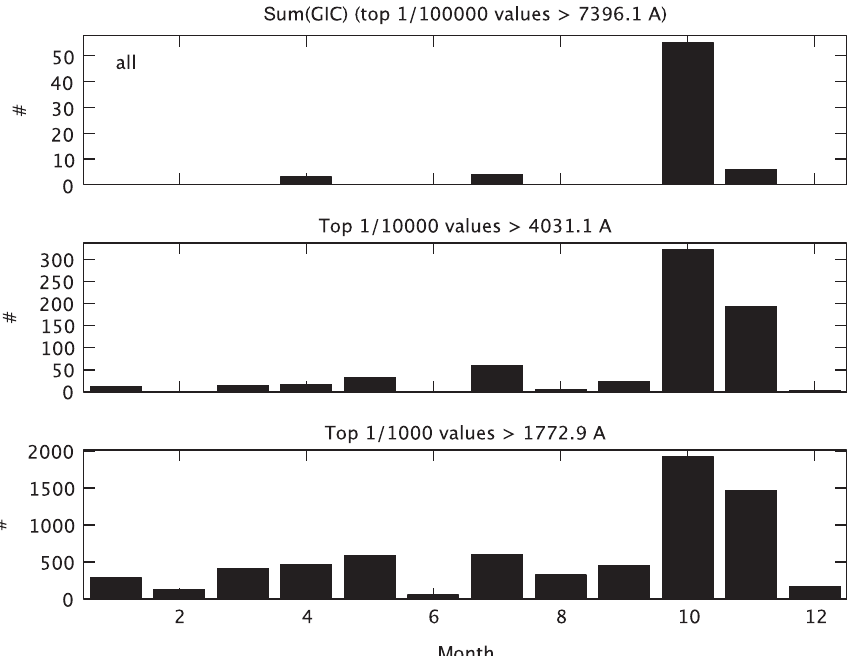
Fig. 7. Seasonal distribution of the largest 1-min GIC sums in the European high-voltage power grid. From top to bottom: occurrence of the top 0.001%, 0.01%, 0.1% of all values.